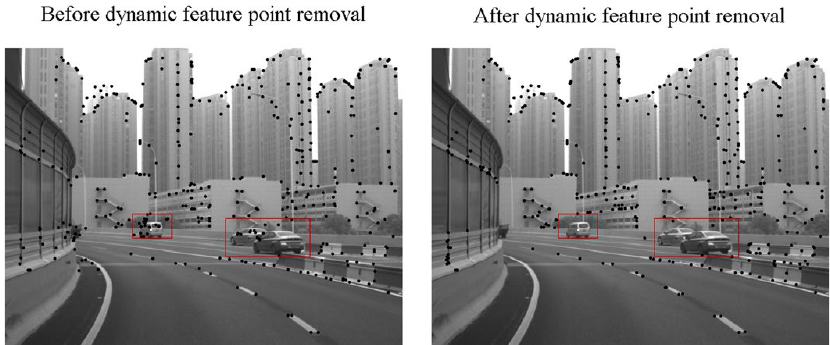
Figure 7. The effect of dynamic feature points removal.